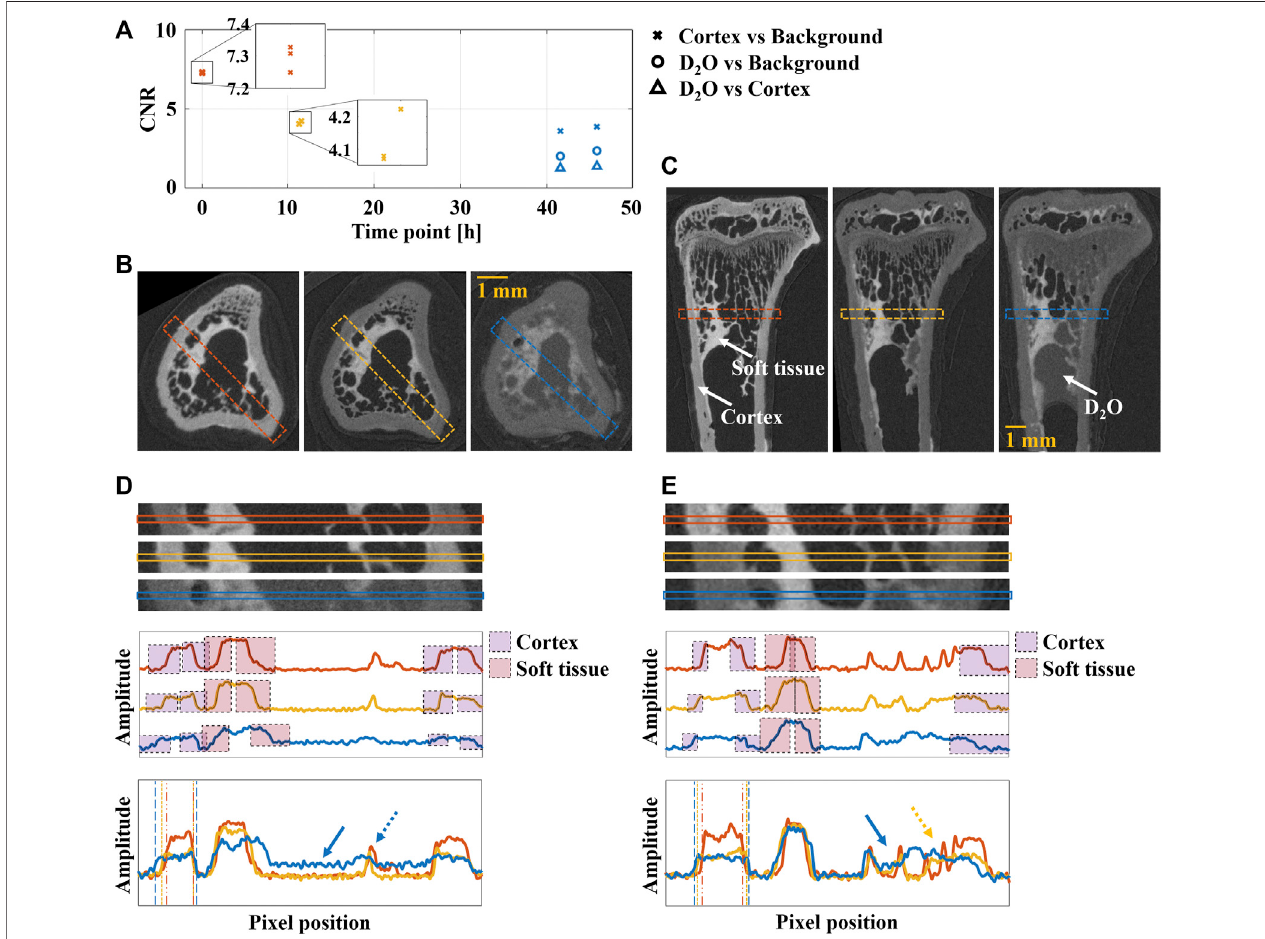
FIGURE 3 | Image analysis of the rat tibiae at different hydration states: dry — red, rehydrated 12 h — orange, rehydrated > 40 h — blue. (A) CNR for cortex vs. background, D 2 O vs. background, and D 2 O vs. cortex at the different hydration states, with zoom-ins of the fi rst two hydration state for easier identi fi cation of the individual data points. Free D 2 O was only noticed in the third set of images of the two tibiae that were rehydrated for > 40 h (shown in B and C). (B) Transverse and (C) sagittalslicesoftibiawithregionsforlinepro fi lesindicatedwithdashedsquare.Cortex,softtissue,andD 2 Oareindicatedwithwhitearrows. (D) and (E) Zoom-inof theregionsinBandC,respectively,withcorrespondingseparatedandoverlaid linepro fi les.Edgesused foredgesharpnessanalysisareindicatedwithcoloredsquares (cortex — purple, soft tissue — red). In the overlaid line pro fi les, thickening of the cortex with increased hydration is indicated with dashed lines. The arrows indicate increased signal due to D 2 O (solid), and reduced contrast for inner structures (dashed). The yellow dashed arrow indicates reduced contrast for inner structures after 12 h of